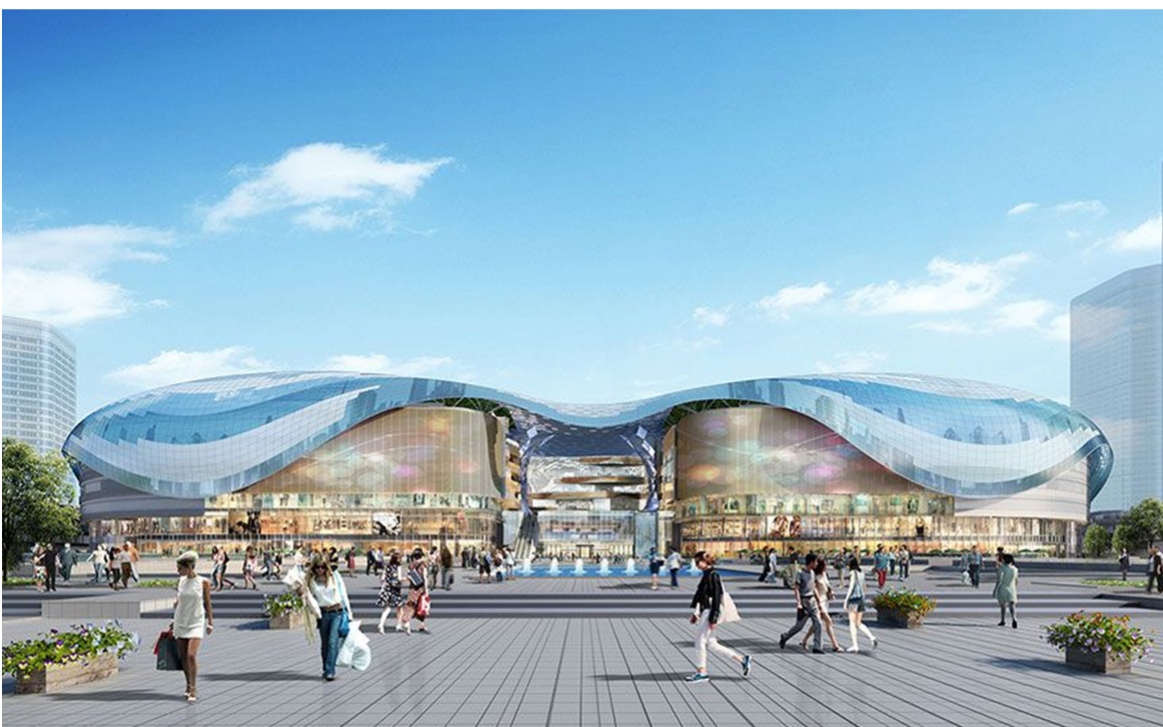
Fig. 3. Jinji Lake mall, Souzhou,